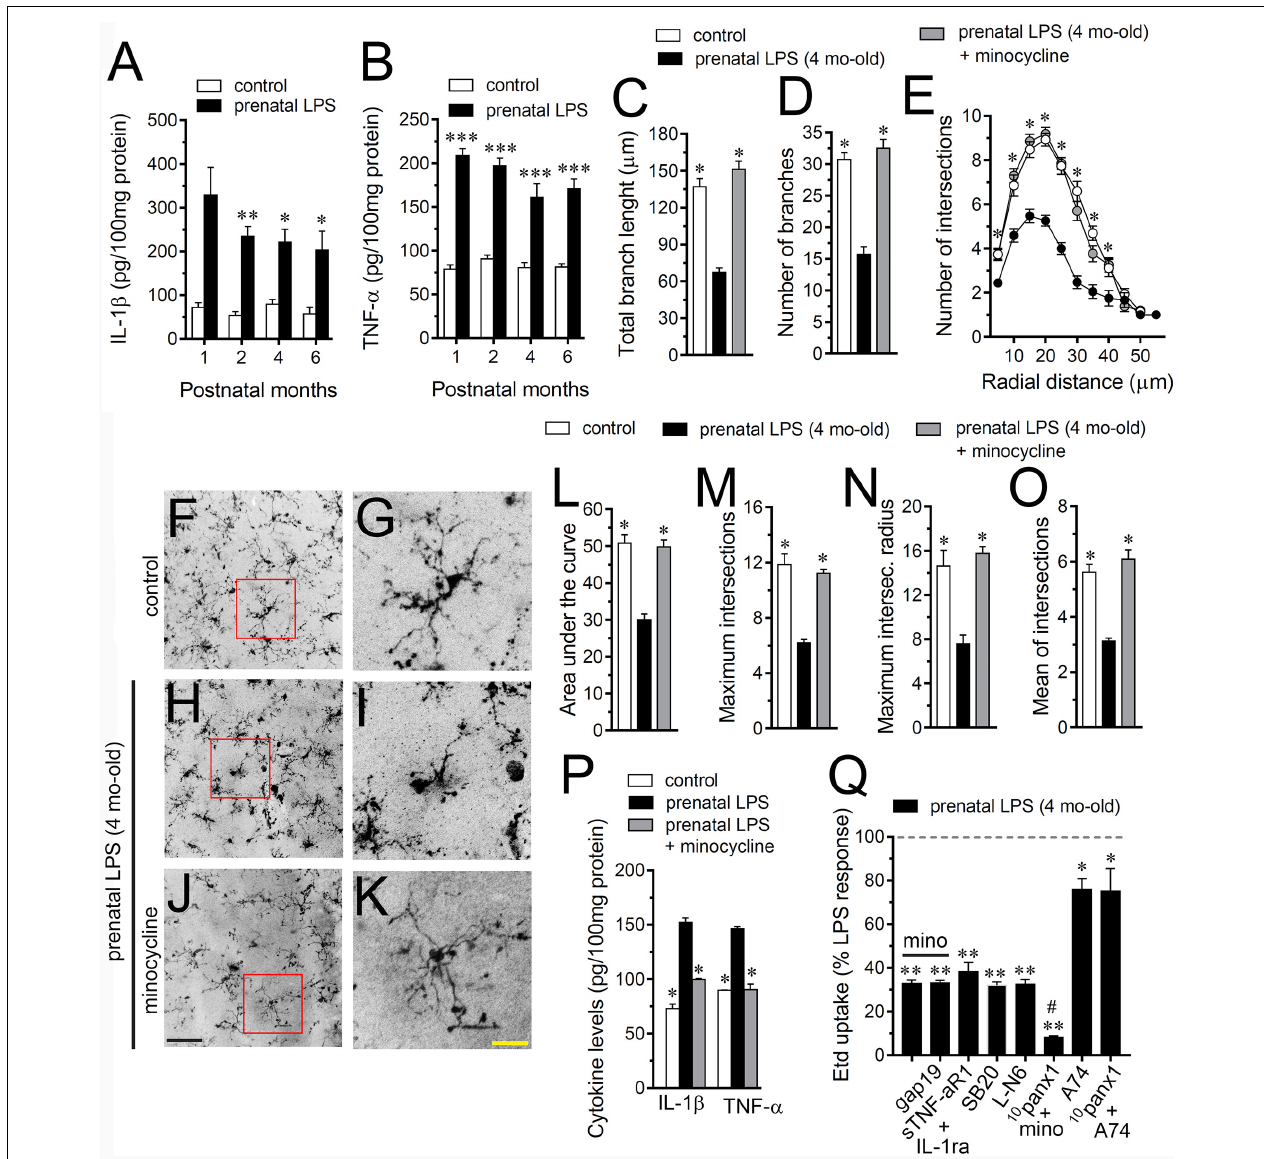
FIGURE 2 | Microglia and IL-1 β /TNF- α /p38 MAP kinase/iNOS signaling participate in the prenatal LPS-induced opening of astrocyte Cx43 hemichannels on offspring hippocampus. Averaged data of hippocampal levels of IL-1 β (A) and TNF- α (B) from control offspring (white bars) or prenatally LPS-exposed offspring (black bars) following different postnatal periods. ∗∗∗ p < 0.0001, ∗∗ p < 0.005, ∗ p < 0.05 versus control, two-way ANOVA Bonferroni’s post hoc test, mean ± S.E.M., n = 3. (C,D) Averaged data of total branch length (C) and number of branches (D) by hippocampal microglia in acute slices from control offspring (white bars) or prenatally LPS-exposed offspring (black bars) of 4 months old. Also shown are the effects of treatment with 50 nM minocycline for 2 h in acute slices prenatally LPS-exposed offspring of 4 months old (gray bars). ∗ p < 0.0001 versus LPS, one-way ANOVA Dunnett’s post hoc test, mean ± S.E.M., n = 3. (E) Averaged data of Sholl analysis by hippocampal microglia from control offspring (white circles) or prenatally LPS-exposed offspring of 4 months old alone (black circles) or plus treatment with 50 nM minocycline (gray circles). ∗ p < 0.001 versus LPS, two-way ANOVA Tukey’s post hoc test, mean ± S.E.M., n = 3. (F–K) Representative Iba-1 (black) positive hippocampal microglia in acute slices from control offspring (F,G) or prenatally LPS-exposed offspring of 4 months old alone (H,I) or plus treatment with 50 nM minocycline (J,K) . Insets of microglia (G,I,K) were taken from the area depicted within the red squares in (F,H,J) . (L–O) Averaged data of area under the curve of Sholl analysis (L) , maximum intersection (M) , maximum intersection radius (N) , and mean of intersections (O) by hippocampal microglia from control offspring (white bars) or prenatally LPS-exposed offspring of 4 months old alone (black bars) or plus treatment with 50 nM minocycline (gray bars). ∗ p < 0.0001 versus LPS, one-way ANOVA Dunnett’s post hoc test, mean ± S.E.M., n = 3. (P) Averaged data of hippocampal levels of IL-1 β and TNF- α from control offspring (white bars) or prenatally LPS-exposed offspring of 4 months old alone (black bars) or plus treatment with 50 nM minocycline (gray bars). ∗∗∗ p < 0.0001, versus control, two-way ANOVA Bonferroni’s post hoc test, mean ± S.E.M., n = 3. (Q) Averaged data normalized to the maximal effect (dashed line) induced by prenatal LPS exposure on Etd uptake by hippocampal astrocytes in acute slices from 4 months old offspring exposed to the following pharmacological agents: 50 nM minocycline, 50 nM minocycline + 100 µ M gap19, sTNF- α R1 + IL-1ra (300 ng/ml each), 1 µ M SB203580, 1 µ M L-N6, 50 nM minocycline + 100 µ M 10 panx1, 200 nM A740003 or 100 µ M 10 panx1 + 200 nM A740003. ∗∗ p < 0.0001, ∗ p < 0.005 versus LPS, # p < 0.0001 versus minocycline, one-way